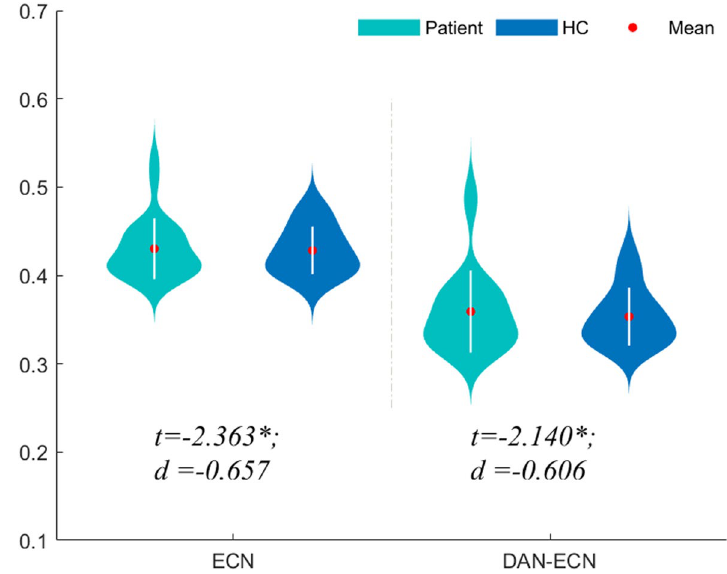
Fig.4 Subnetwork connections of fMRI in intra-network and inter-network comparison between patient group and HC group. The comparisons between two groups were assessed by using two-simple t test with age, sex and FD as covariates. DAN, dorsal attention network; ECN, executive control network; HC, healthy control; d, the effect size Cohen’s d. * P < 0.05